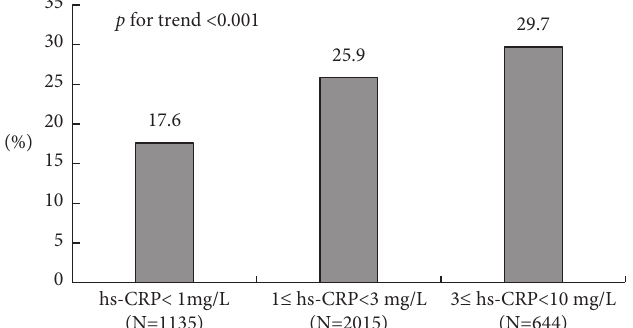
Figure 2: When subjects were divided into three categories based on the baseline hs-CRP levels, a trend relationship between hs-CRP levels and incident hypertension was observed ( p <